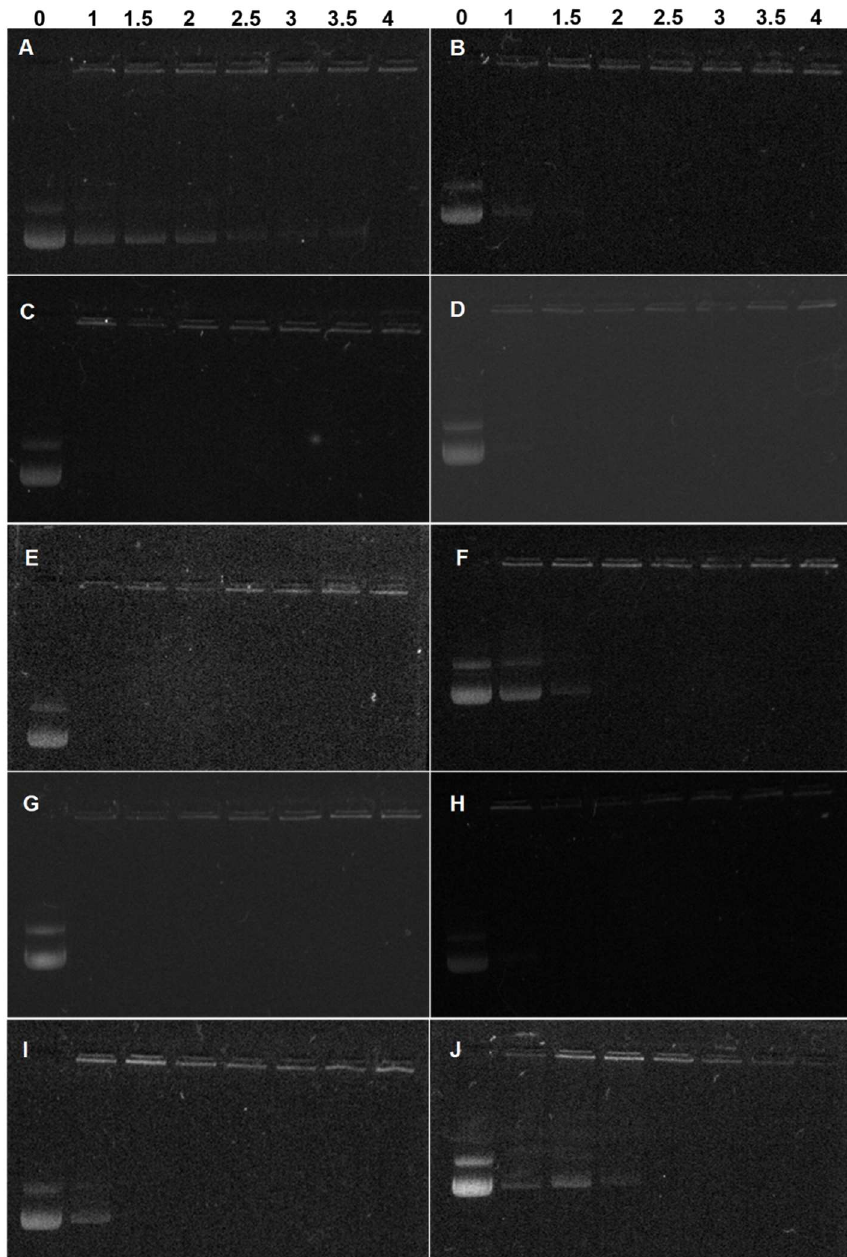
Figure 4. Electrophoretic mobility of pDNA in the polyplexes formed with lignin graft copolymers ( A ) LP-03, ( B ) LP-05, ( C ) LP-06, ( D ) LP-11, ( E ) LP-12, ( F ) LP-14, ( G ) LP-16, ( H ) LP-17, ( I ) LP-20 and ( J ) PEI (25 kDa) at various N/P ratios; Data for ( F ) LP-14 and ( G ) LP-16 were reported previously [18]